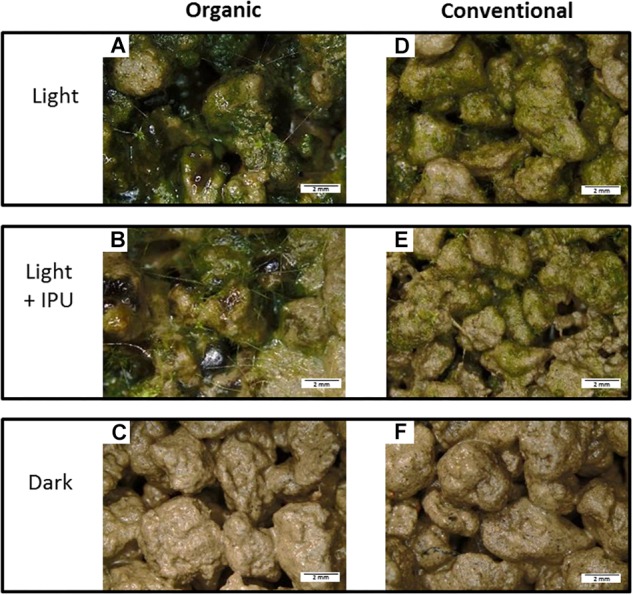
Photosynthetic microbial biofilms growing on soil aggregates from Organic (A–C) or Conventional (D–F) cropping system, along the different incubation conditions (50 days). The Dark condition (C,F) did not show visible algae growth. Various phenotypes of indigenous cyanobacteria and algal colonies covered the aggregate surfaces of incubated microcosms in Light (A,D) and Light + IPU conditions (B,E) (see Table 1 for acronym description). The filaments bridging between aggregates (A,B) are probably cyanobacteria and moss rhizoids.